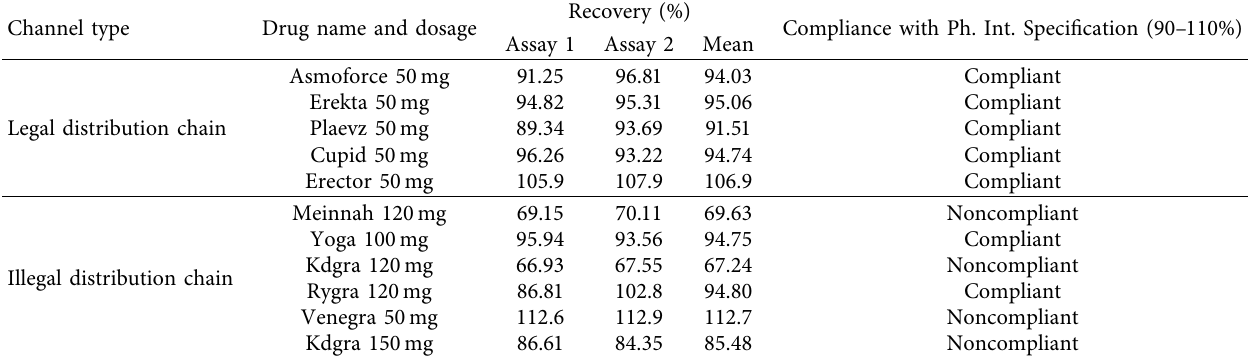
Table 9: Determination of sildenafil content in